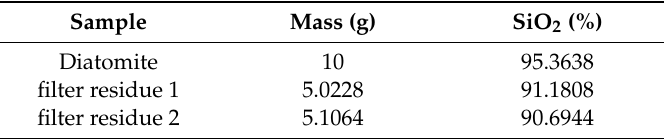
Table 1. The SiO 2 content in diatomite and filter residue.